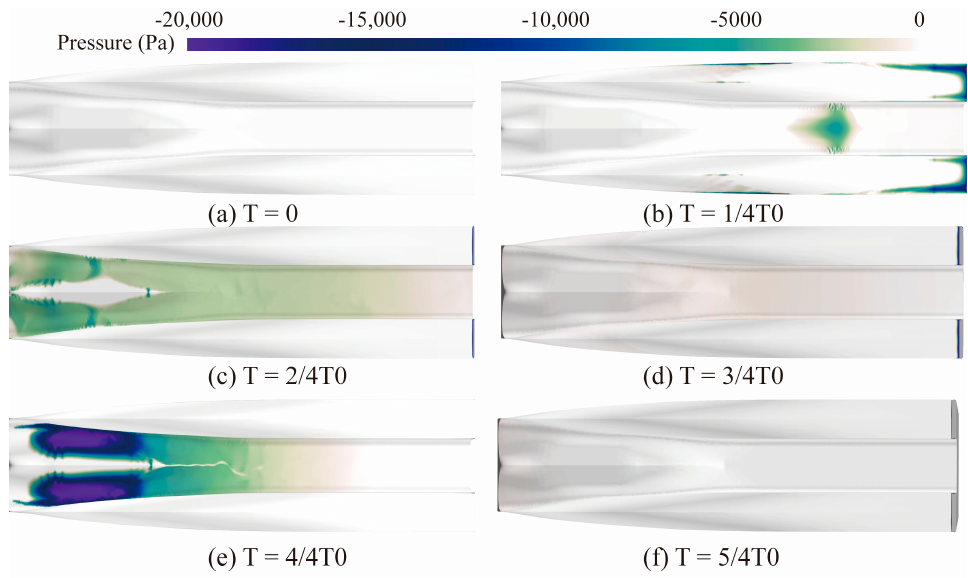
Figure 24. Pressure distribution at the bottom of the USV under 7 level sea state with the 0° wave direction (Negative pressure area).